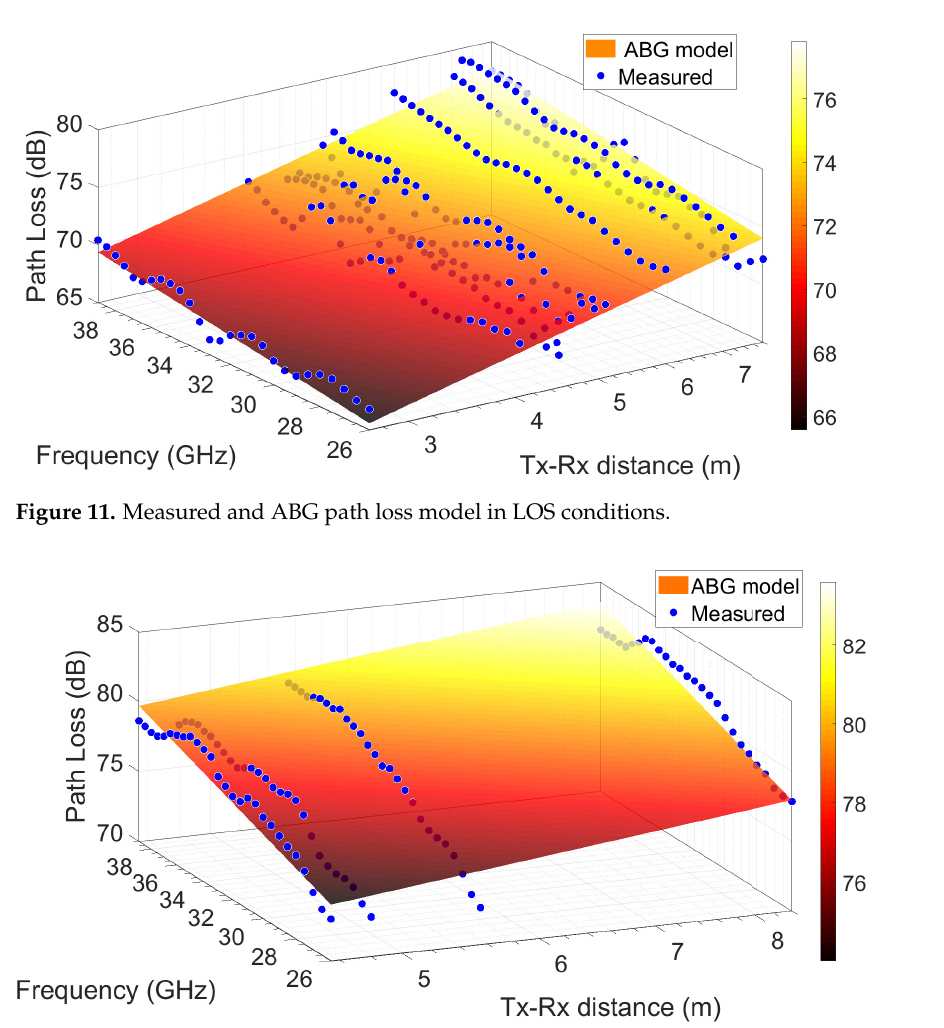
Figure 12. Measured and ABG path loss model in OLOS conditions. Table 6. Parameters of the multi-frequency ABG